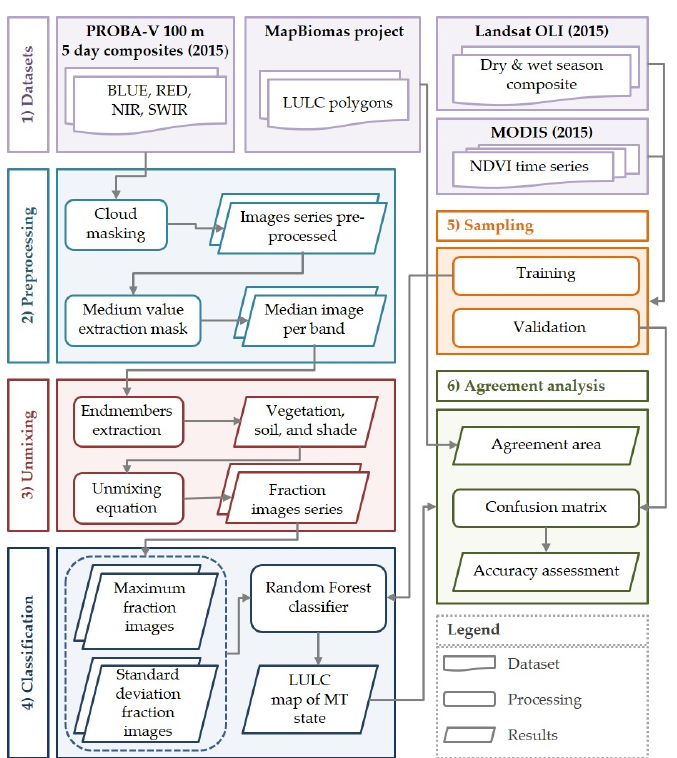
Figure 2. Processing steps of the land use and land cover classification of Mato Grosso state. NIR, near infrared; SWIR, shortwave infrared; LULC, land use and land cover; OLI, Operational Land Imager; MODIS, Moderate Resolution Imaging Spectroradiometer; NDVI, normalized difference vegetation index; and MT, Mato Grosso.